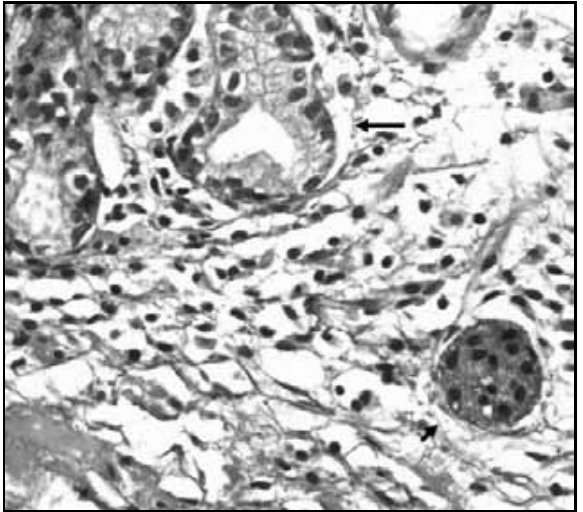
Figure 2 – Immunoreactive cells to chromogranin in diffuse (long arrow) and nodular (short arrow) endocrine cell hyperplasia of patient with ABG (IHQ staining, 400×) ABG: atrophic body gastritis; IHQ: